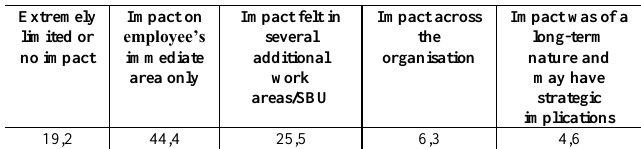
Table 7: Impact of this employee on the organisation